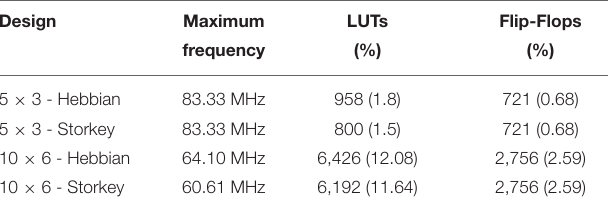
TABLE 2 | Frequency limit and resource utilization estimated in simulation for Xilinx 7-series